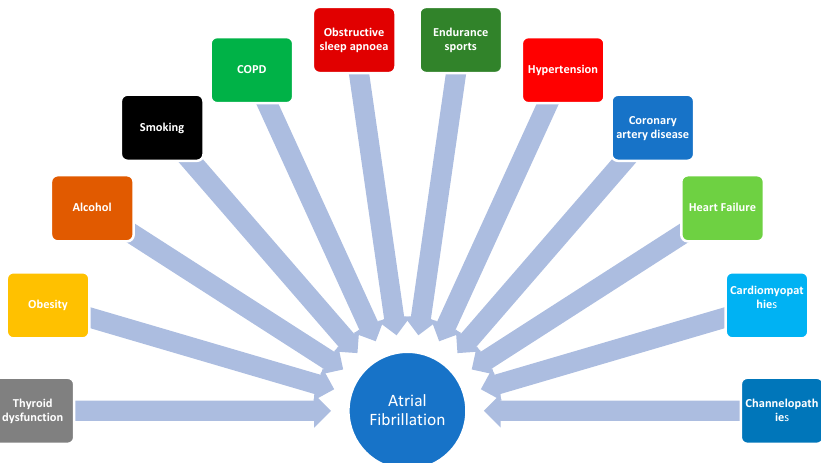
Figure 1. Common causes of atrial fibrillation. COPD: chronic obstructive pulmonary disease.